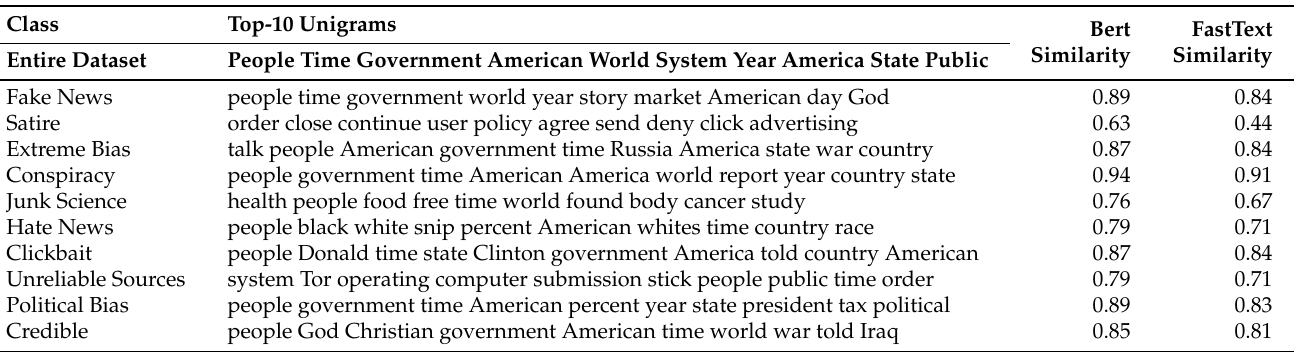
Table 3. Top-10 unigram similarity between the entire dataset and each class.